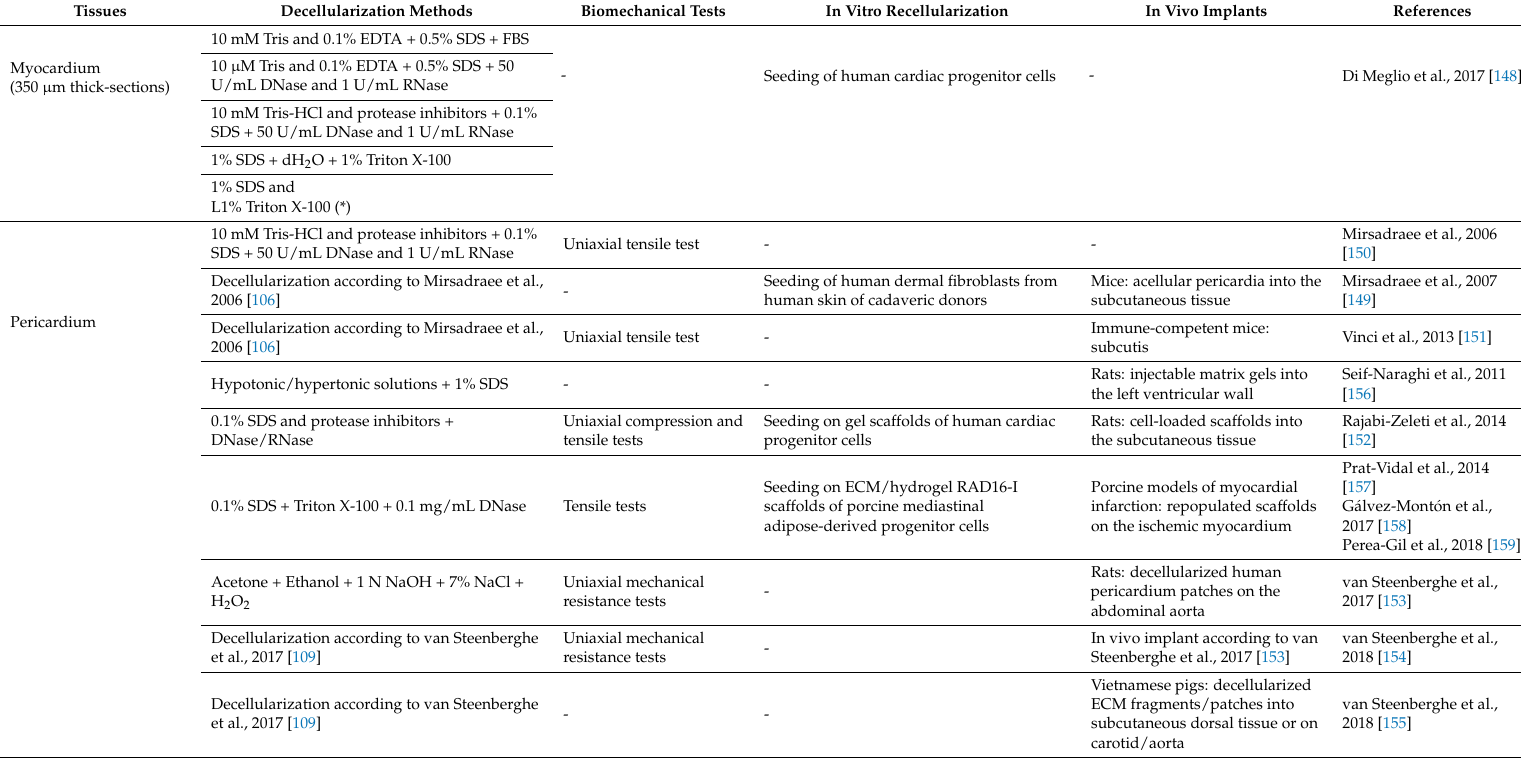
SDS, sodium dodecyl sulfate; DNase, deoxyribonuclease; RNase, ribonuclease; dH 2 O, deionized water; + means that separate cycles were performed; ‘and’ means that a mixture was performed between different substances; (*) best